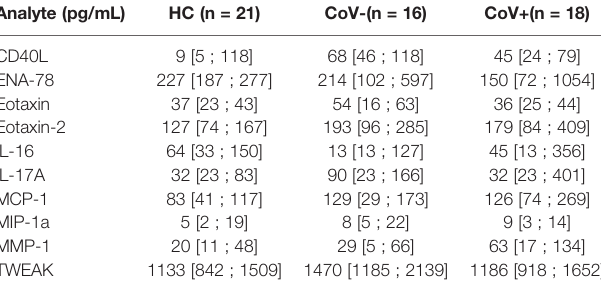
TABLE 2 | Median serum concentration, 25% quartile and 75% quartile in pg/mL of analytes showing no signi fi cant differences in specimen from healthy control (HC) volunteers, symptomatic, COVID-19 negative tested patients (CoV-) and symptomatic, COVID-19 positive tested patients